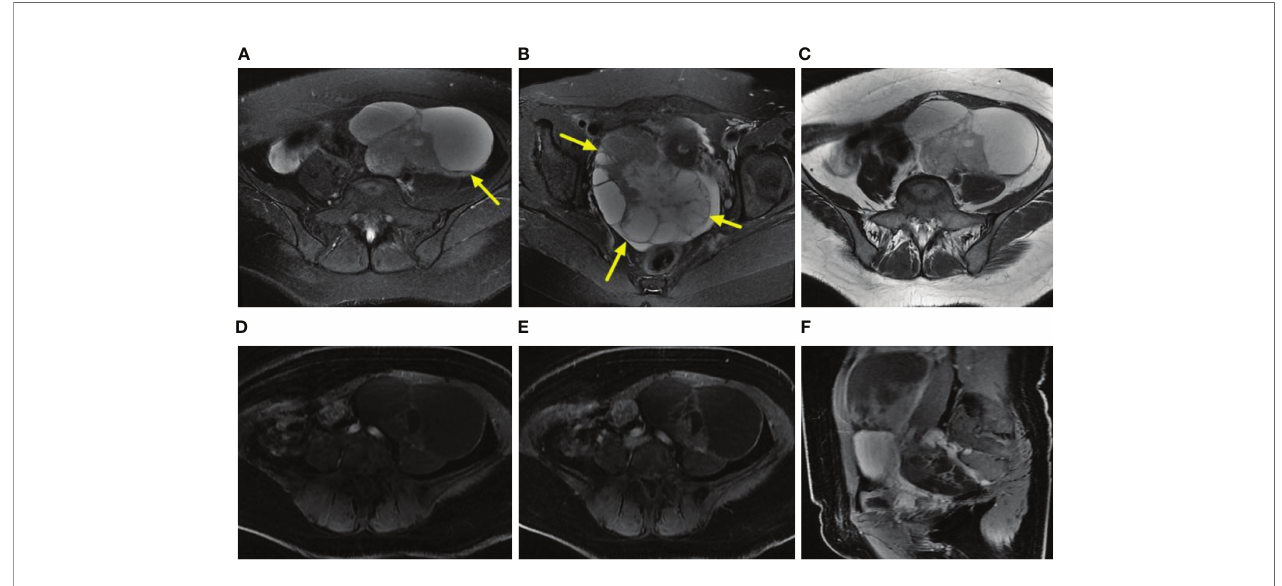
FIGURE 2 | (A – F) Axial FS T2WI and T2WI showed multiple cystic solid masses in both ovaries [yellow arrow, (B) ], and the liquid-liquid plane was visible in part of the capsule [yellow arrow, (A) ]. In the arterial period, the solid region of the lesion revealed moderate enhancement (i.e., similar to that of the gluteal muscle) (D) . In the venous and delayed periods, the solid region of the lesion displayed severe enhancement (i.e., more than that of the gluteal muscle) (E, F) .